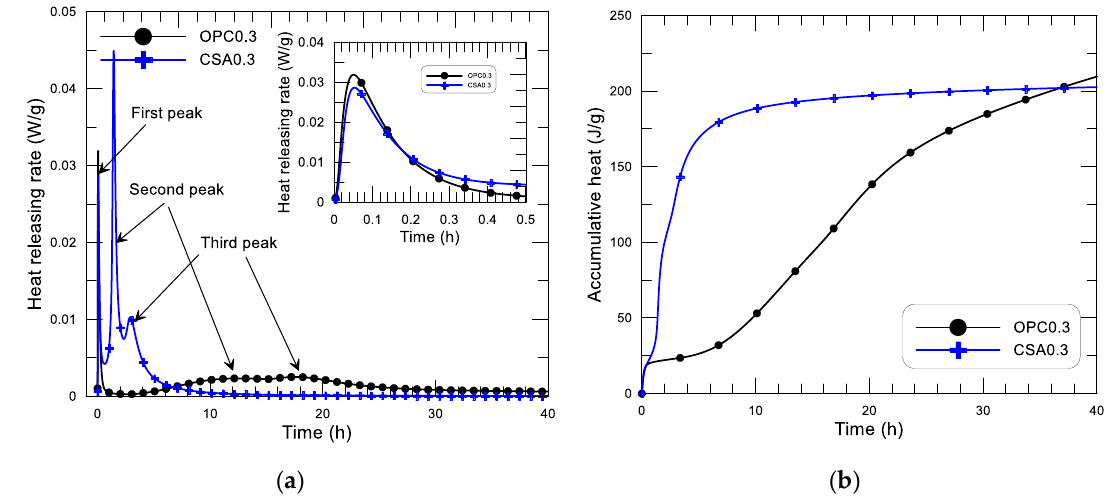
Figure 6. Diagram of releasing rate of hydration heat ( a ), accumulative heat ( b ), and age of CSA and OPC paste with w/c of 0.3.